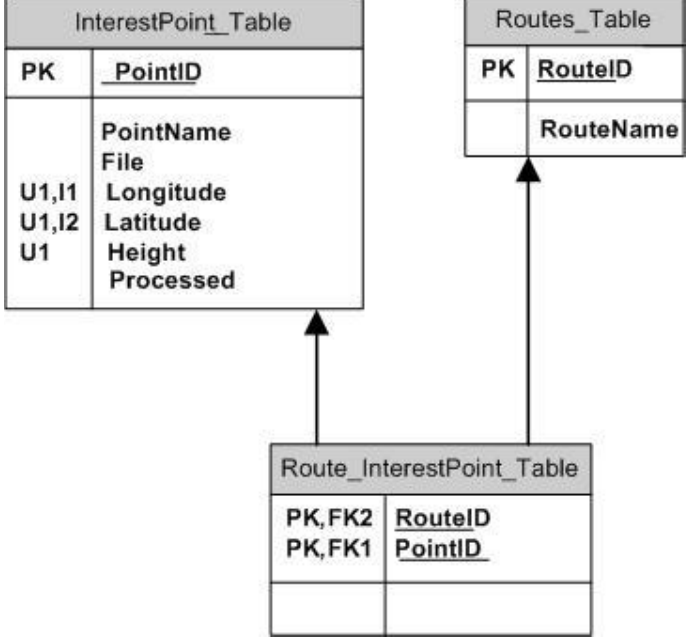
Figure 9. On-board data base with tourist